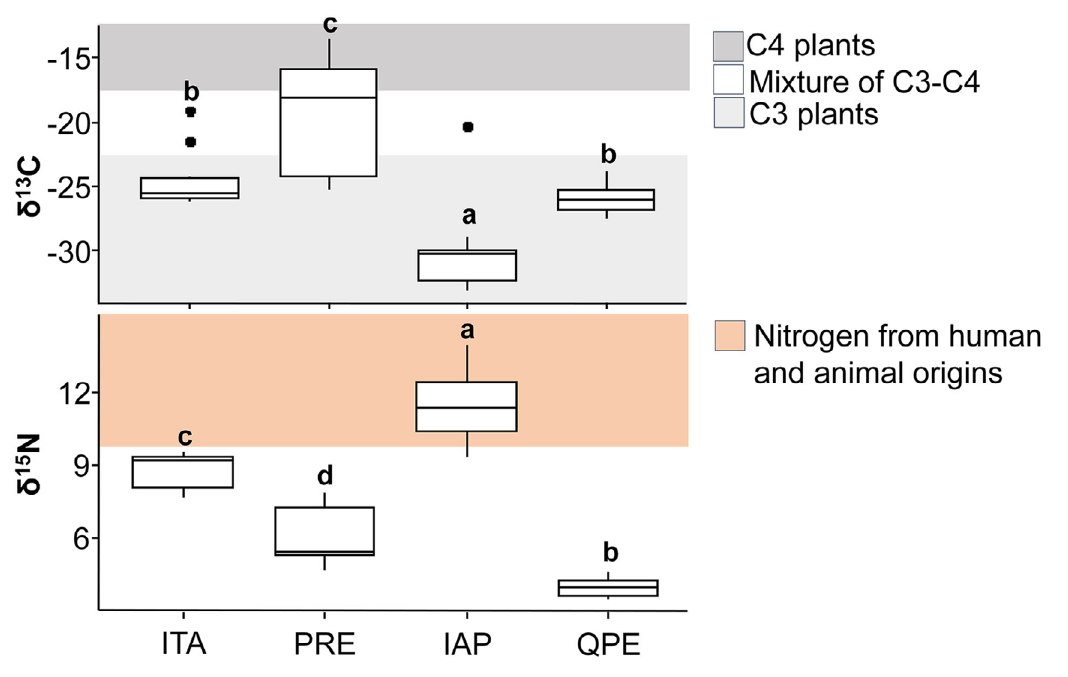
Figure 4. Variation in δ 13 C and δ 15 N for Aegla castro at Itatinga from São Paulo State (ITA: Itaúna stream, Paranapanema sub-basin) and Mauá da Serra (PRE: Preto stream, Tibagi sub-basin), Castro (IAP: Iapó stream, Tibagi sub-basin) and Ponta Grossa (QPE: Quebra Perna stream, Tibagi sub-basin) in Paraná State. Median values are represented by horizontal lines inside boxes (first and third quartiles); vertical lines represent minimum and maximum values. Differences between samples are indicated by different letters (Tukey test, p < 0.05). In C plants, the value of δ 13 C ranges from -22 ‰ to -34 ‰ (light gray), in C plants from -9 ‰ to -16 ‰ (gray), and 3 4 intermediate values between C and C (white) (Vogel, 1993; Boutton, 1996; Ducatti et al ., 2011). δ 15 N values considered to come 3 4 from human and animal origins are indicated by the orange bar (Heaton, 1986; McClelland and Valiela, 1998; Hoffman et al .,